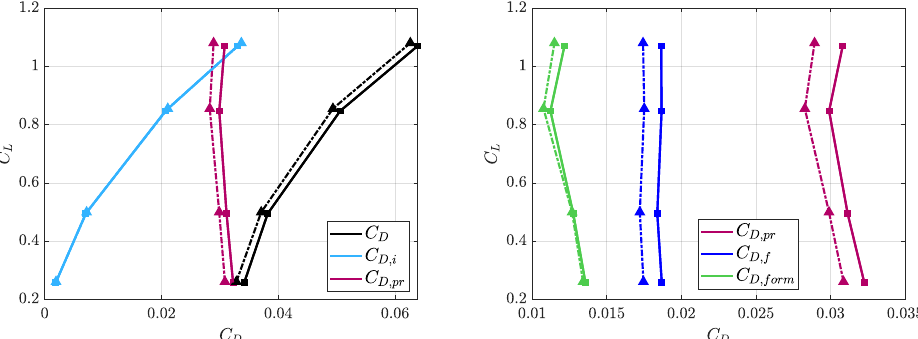
Figure 14. Drag breakdown ( left ) and decomposition of profile drag ( right ). Solid lines with square markers refer to clean configuration; dashed lines with triangular markers refer to riblets configuration.